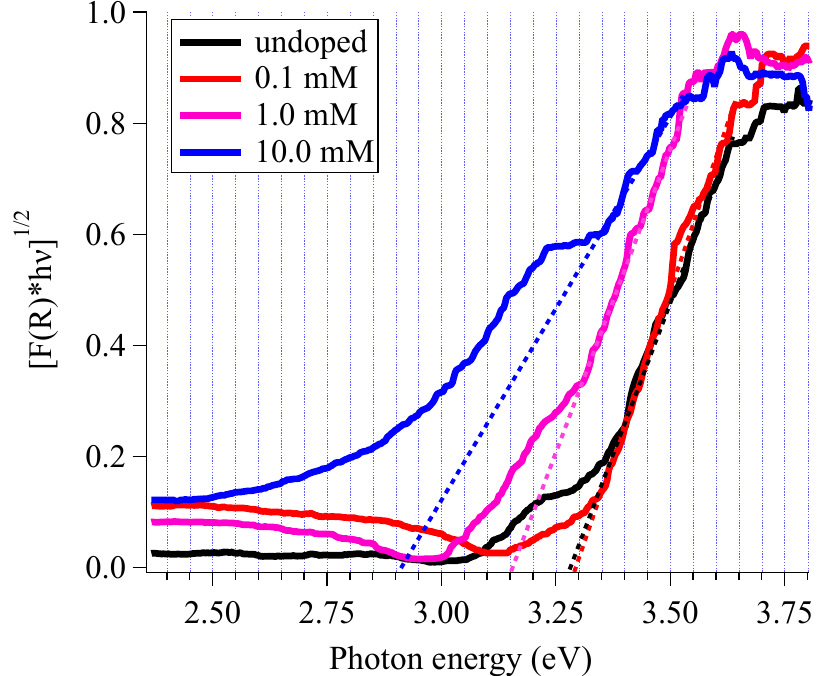
Figure 12. Tauc plots of samples prepared with 0 (black), 0.1 (red), 1.0 (pink), and 1.0 (blue) mM Cu nitrate.